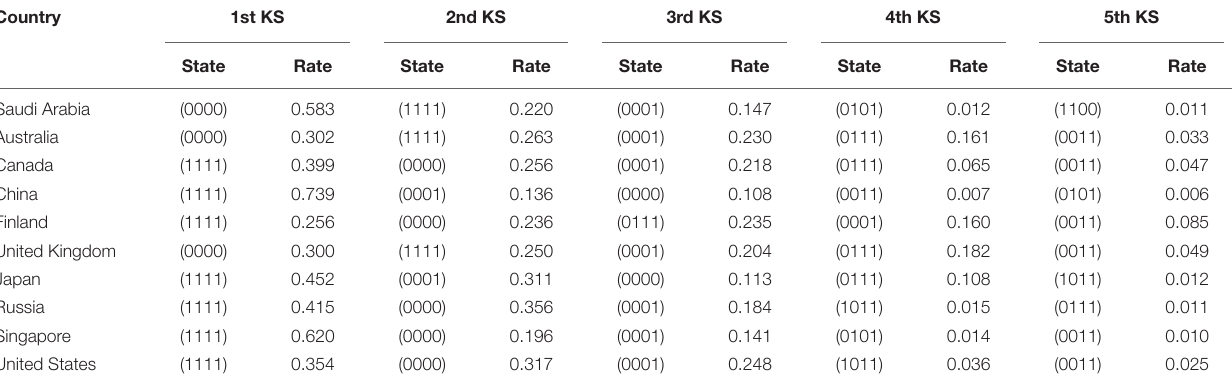
TABLE 5 | Top five knowledge states of content attributes in 10 countries. Country